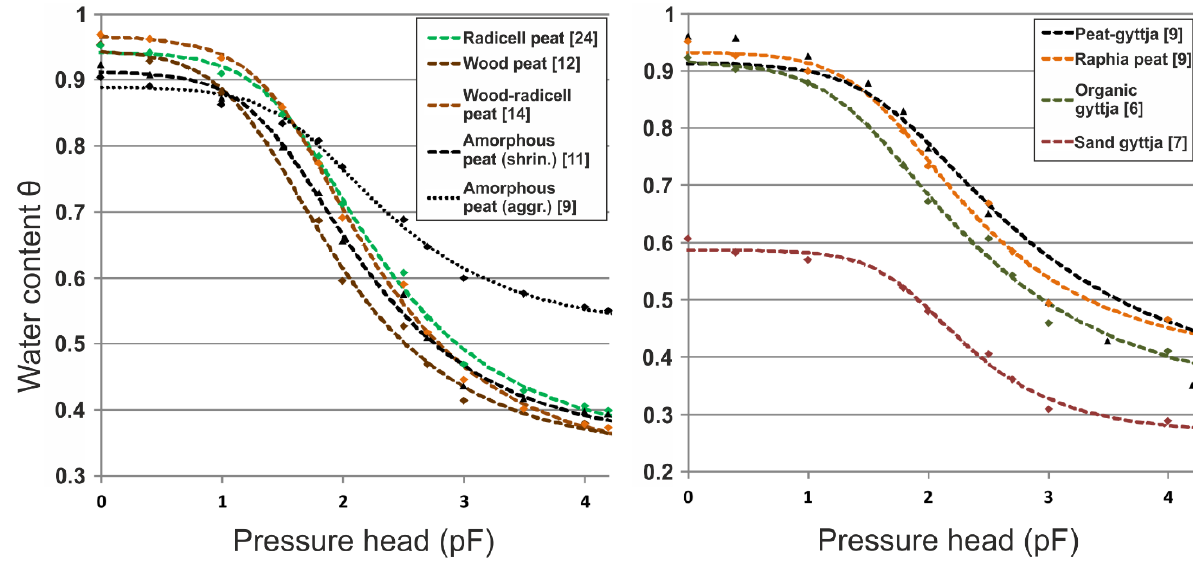
Figure 4. Water retention curves for the different peat